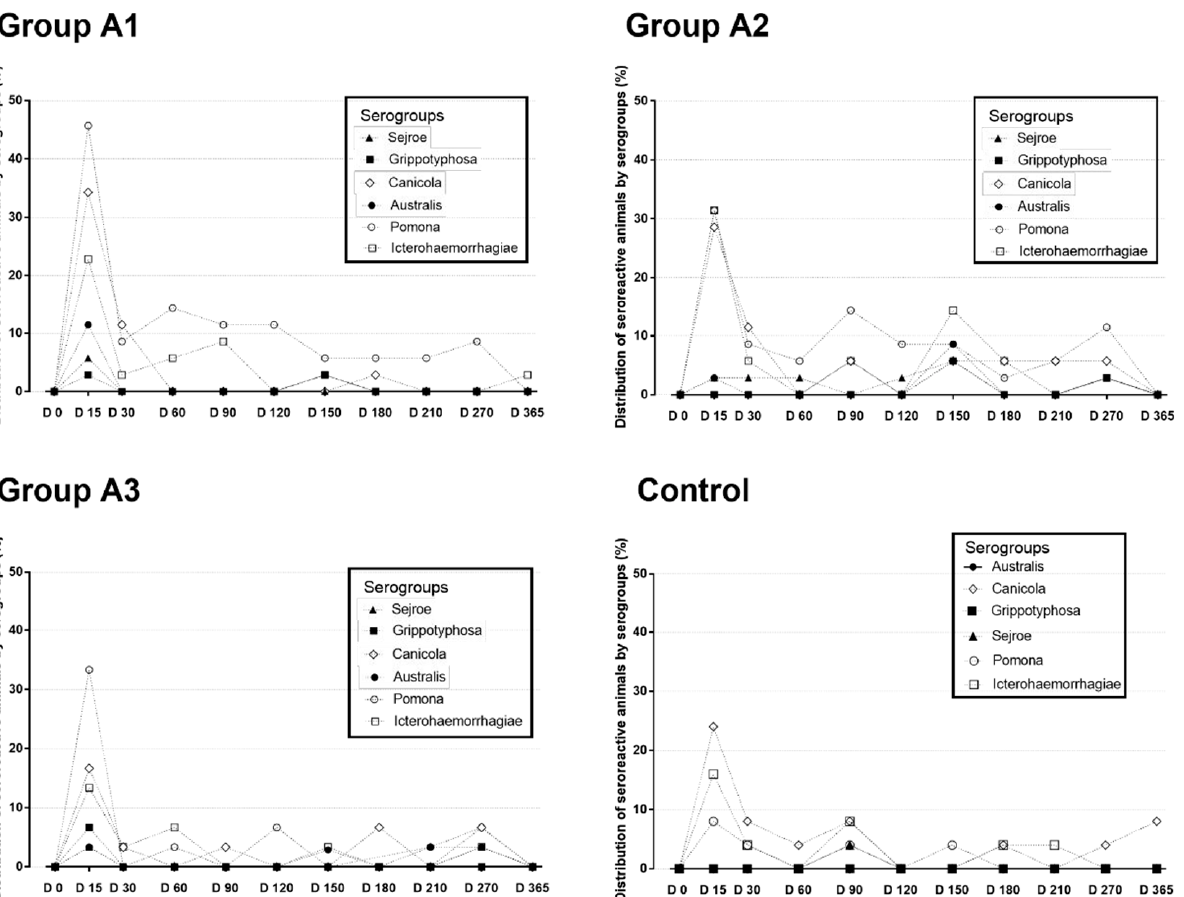
Figure 1. Distribution of seroreactive animals for MAT serogroups between the vaccinated (A1, A2, and A3) and unvaccinated (control) groups.